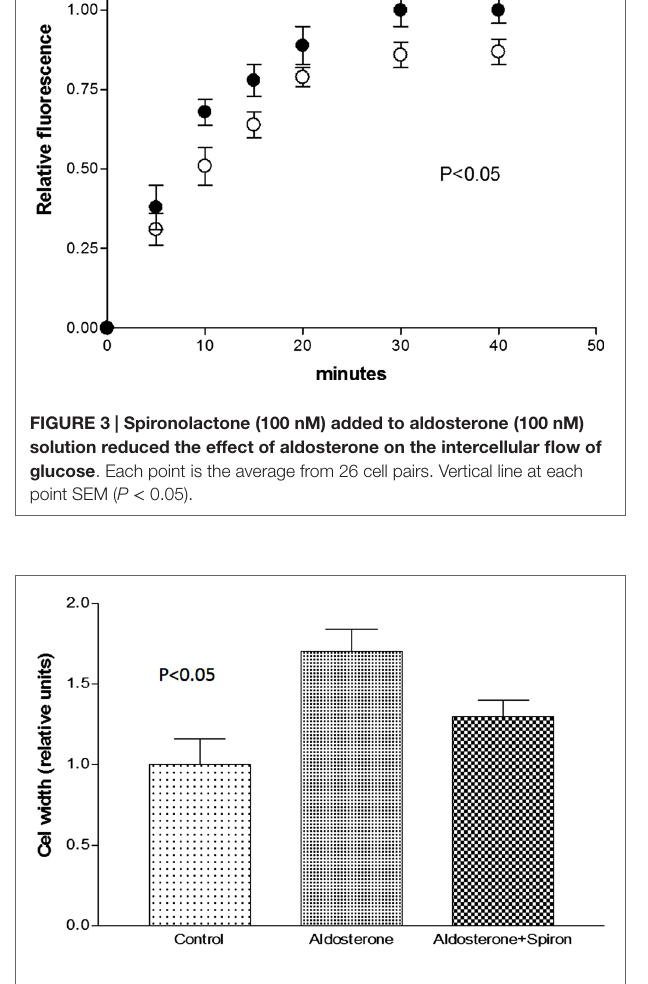
FigUre 4 | increase of cell width elicited by aldosterone (100 nM) and the effect of spironolactone (100 nM) on cell swelling induced by aldosterone . Each bar is the average from 20 cells. Vertical line at each bar SEM ( P < 0.05).